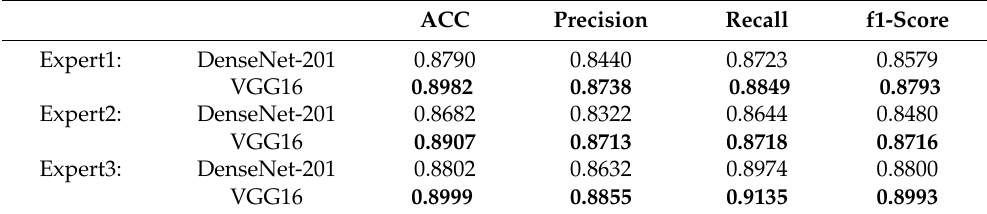
Table 3. Performances of CNN models.